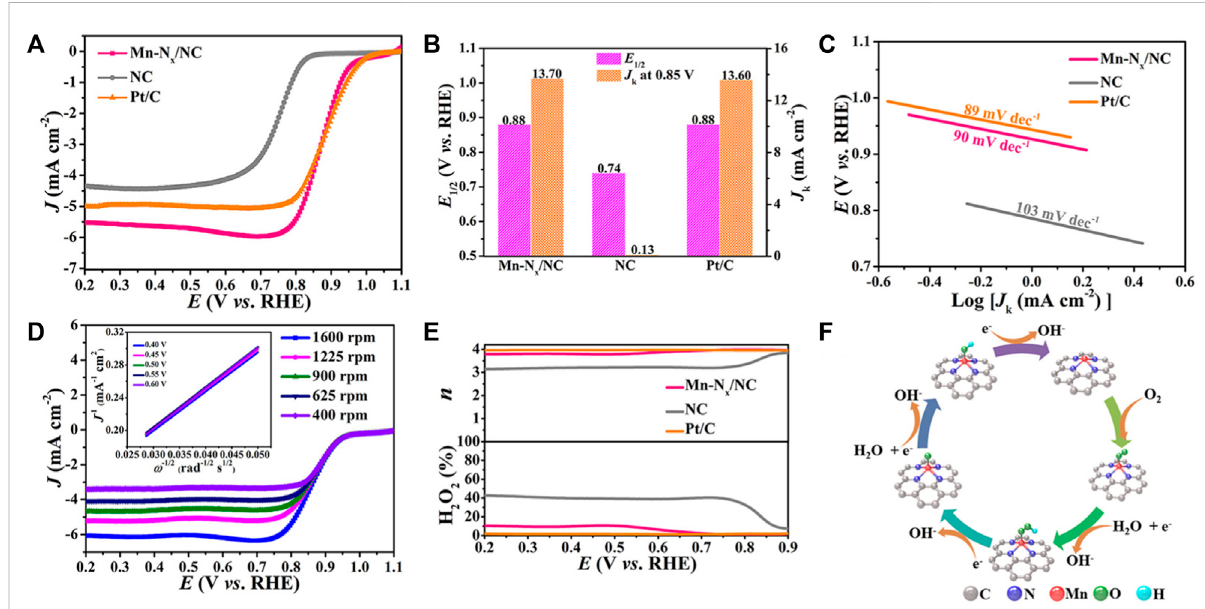
FIGURE 3 Electrocatalytic performance in ORR. (A) LSV curves, (B) E 1/2 and J k , and (C) Tafel slopes of Mn-N x /NC, NC and Pt/C. (D) The LSV curves of Mn- N x /NC at varying rotating speeds, K-L plots in the inset. (E) n and H 2 O 2 yield of Mn-N x /NC and the references. (F) Proposed ORR processes on Mn- N x